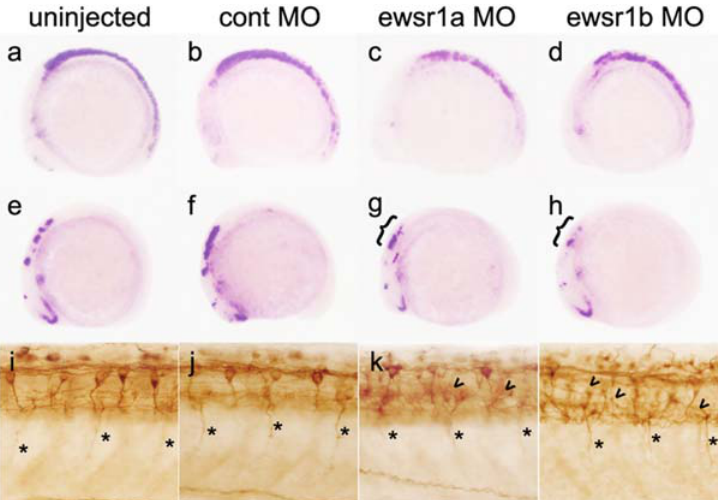
Figure 4.ewsr1MO Injected Embryos Display a Reduction of CNS Neuronal cells and Disorganized Neuronal Network. (a, e and i) uninjected, (b, f and j) control MO, (c, g and k) ewsr1a MO and (d, h and l) ewsr1b MO injected embryo. (a–d) ewsr1a and ewr1b MO injected 12 somite embryos show marked reduction of ngn1 expression in the CNS (lateral view). (e–h) ewsr1a and ewr1b MO injected 12 somite embryos show marked reduction of zash1a expression in the CNS (lateral view). ({) indicate marked reduction in the hindbrain of zash1a . (i–l) Lateral views of the trunk in 24hpf embryos stained with acetylated tubulin (aAT) antibody. Arrowhead identifies disorganized axonal projections in ewsr1 MO injected embryos. Asterisk (*) marks